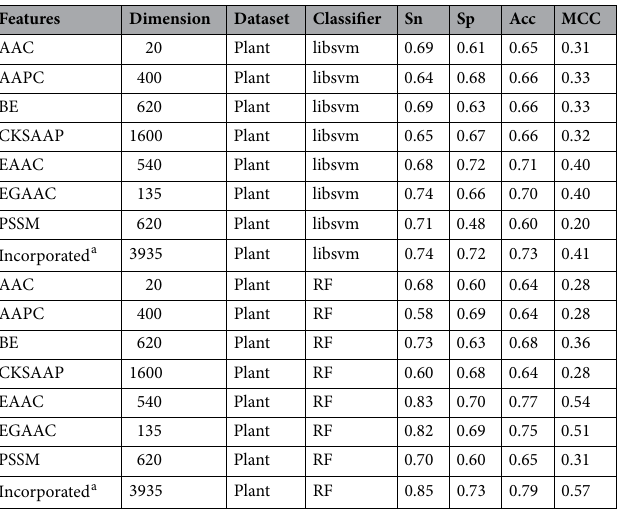
a Table 1. Performance on plant dataset. Stands for the combination of each single feature, which means AAC + AAPC + BE + CKSAAP + EAAC + EGAAC + PSSM.